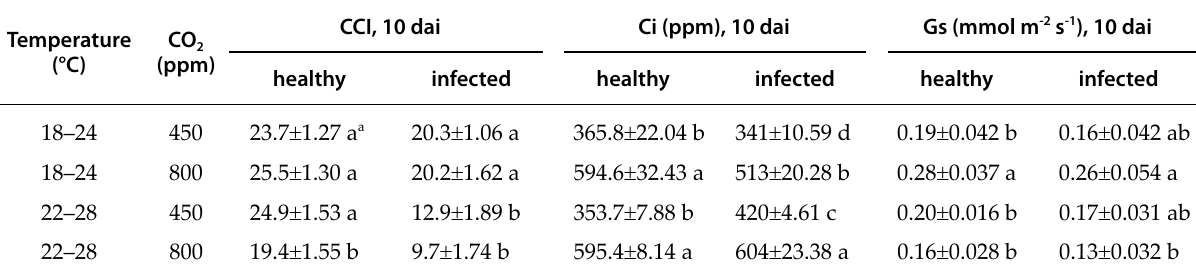
Table 3. Mean chlorophyll content indices (CCI), intercellular carbon dioxide (Ci) and stomatal conductance (gs) in 2nd leaves of zucchini plants grown in different temperature and CO 2 regimes. Data are shown as means ± SE (n ≥5). Average results of five trials.